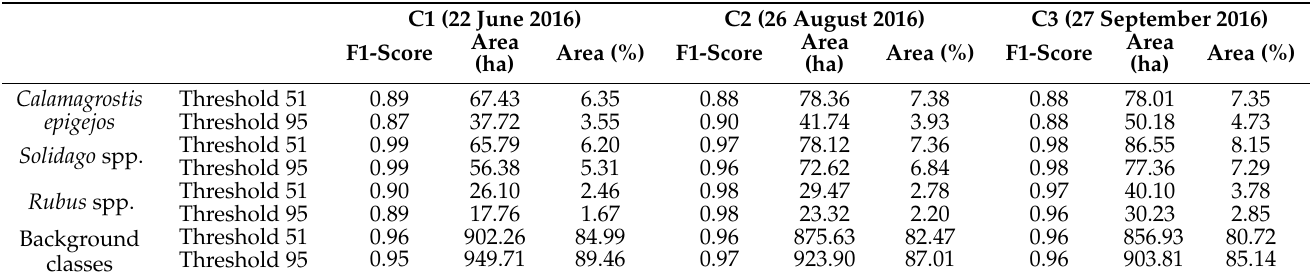
Table 4. Summary of classification accuracy measured by F1-score and the area occupied by